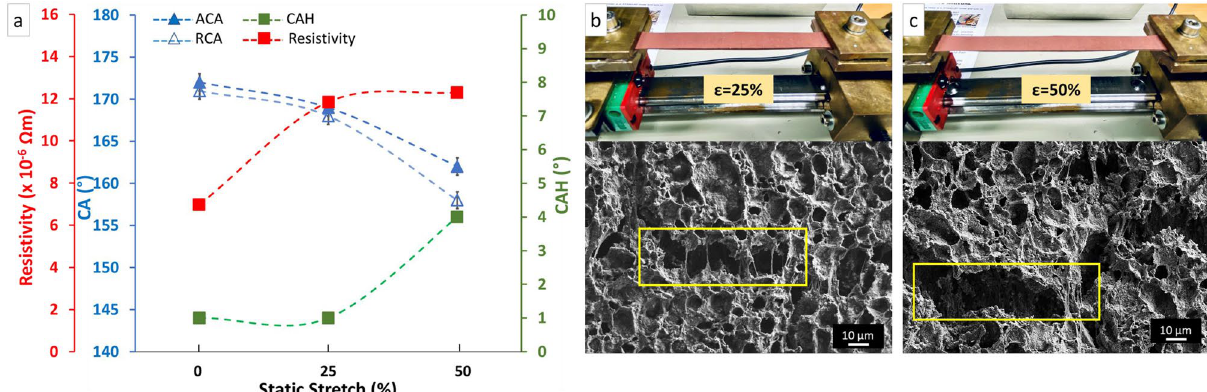
Figure 3. ( a ) The contact angles, contact angle hysteresis, and resistivity of non-stretched and stretched samples at 25% and 50% of tensile strain in a static stretch test. Photos of stretching test setup and the SEM images of static stretched samples at ( b ) 25% and ( c ) 50% of tensile